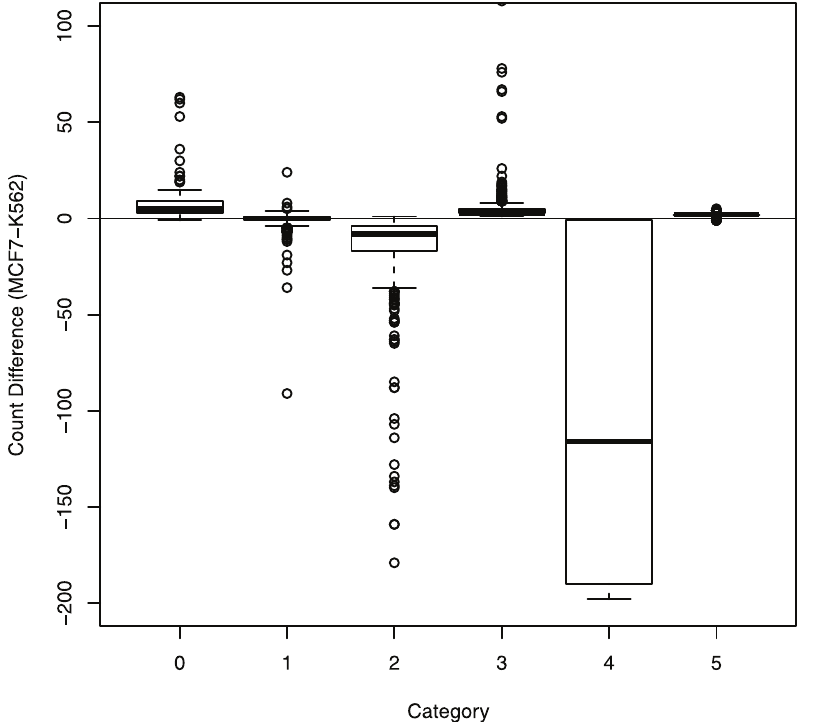
Figure 4. Boxplot of the count differences for each category for the real data. The x -axis is the category that the fragment pair was classified into. The y -axis is the count in the cell line MCF7 minus the count in the cell line K562 for the fragment.